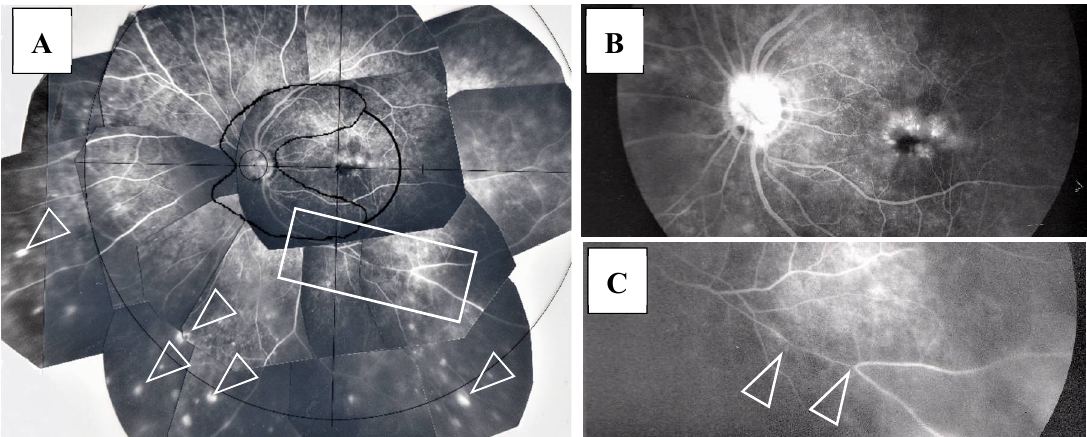
Figure 7. ( A – C ) Images of the left eye of Case 5, a 64-year-old female in Group I with a max IOP of 28 mmHg. Photographs of FFA mounted on a transparent sheet with different zones ( A ) and FFA in the late stage ( B , C ). Abnormalities of the retina existed from Zone I to III. Numerous nodules (arrowheads in A ) were found mainly in Zone III. Diffuse fluorescein leakage of the optic nerve head and macular edema were found in the late stage ( B ). Image C is an enlargement of the boxed area in A . The retinal vein became very narrow with a long length (arrowheads in C ).